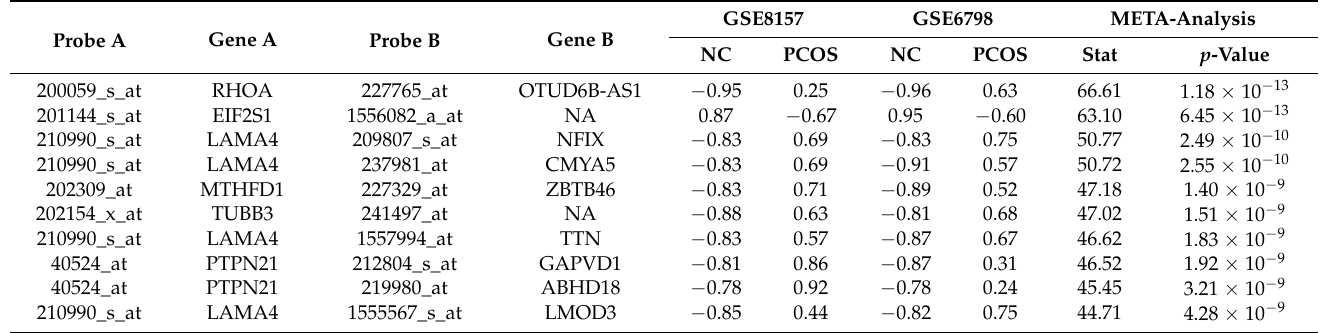
Table 2. Top 10 Significant results of differentially coexpressed genes in